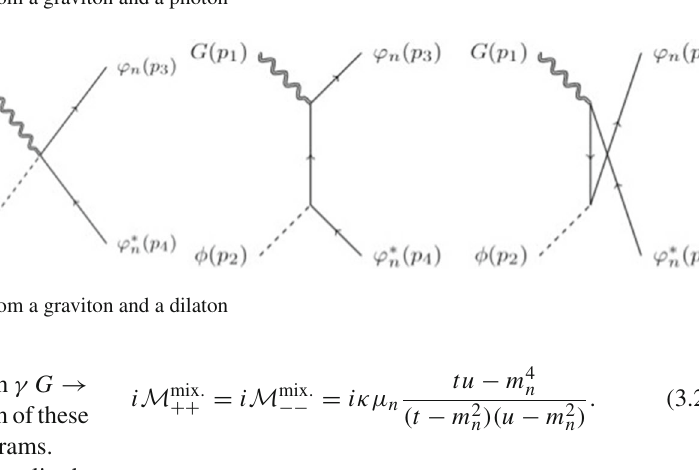
Fig. 3 Feynman diagrams for the mixed pair production from a graviton and a photon